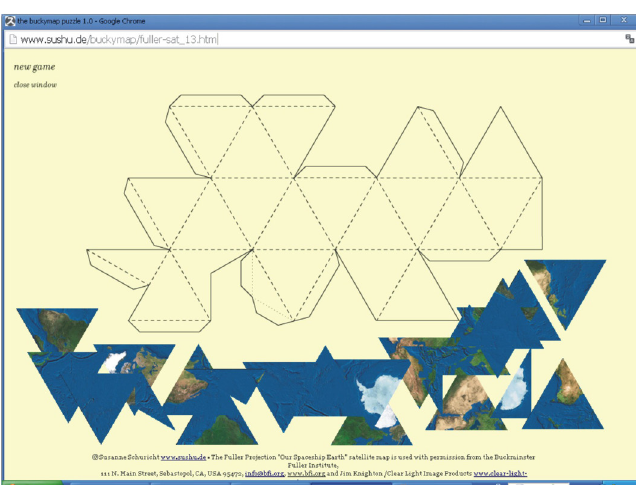
Fig. 31. Puzzle with a map of the World on a regular icosahedron (source: S. Schuricht